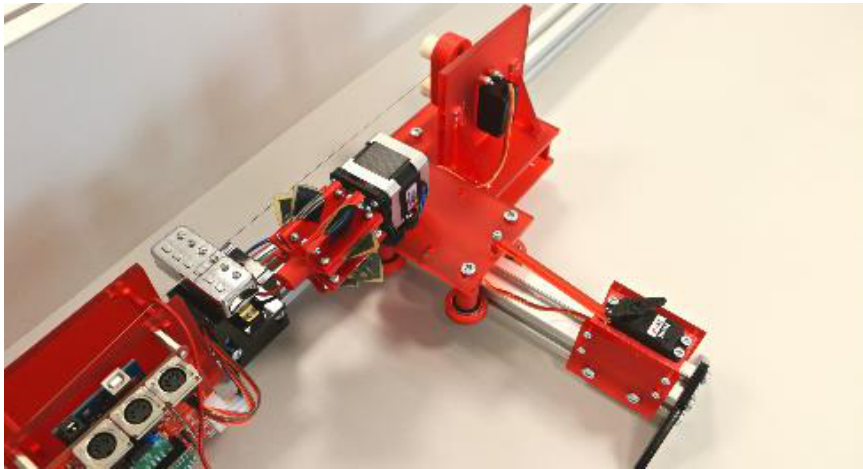
Fig. 6. Group III: Note here the servo driving a cam to advance or retard the picking mecha-